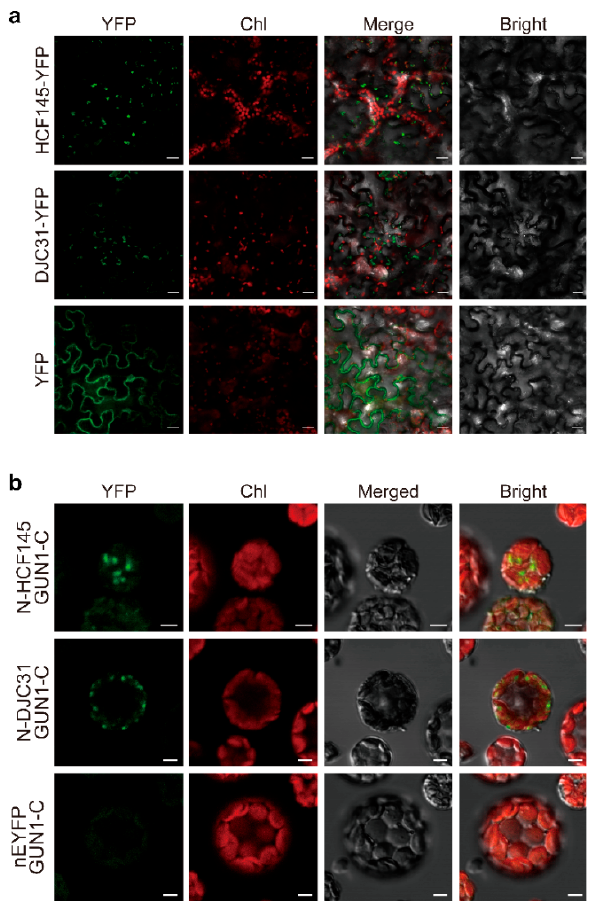
Figure 2. ( a ) Confocal observation showing the chloroplast localization of DJC31 and HCF145. Both proteins were fused upstream of YFP and transiently expressed in tobacco leaves by infiltration. Representative images were collected under the YFP, chlorophyll, bright field channels, and merged (Scale bars, 20 μ m), ( b ) BiFC assay demonstrating the interactions between GUN1 and its two interacting proteins. Arabidopsis protoplasts were transfected to express GUN1 and each of its candidate interacting proteins fused with the C- (cEYFP) and N- (nEYFP) halves of EYFP, respectively, as indicated. nEYFP expressed from the empty pSAT1A-nEYFP-N1 vector served as a negative control. Representative images were collected under the YFP, chlorophyll, bright field channels and merged (Scale bars, 5 µ